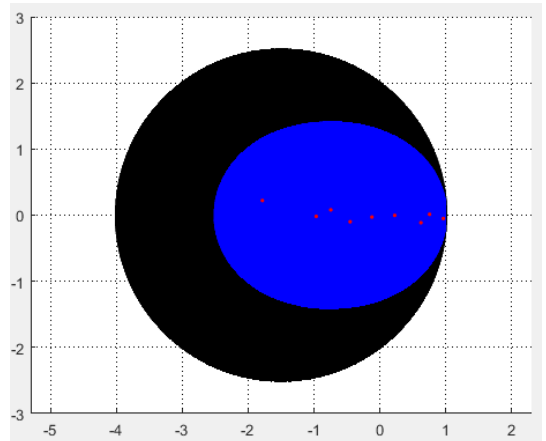
Figure 2. P 2 ( z ) = U 9 ( z ) + 3 U 8 ( z ) − ( 1 − 2 i ) U 7 ( z ) − ( 1 − i ) U 6 ( z ) + iU 4 ( z ) − U 2 ( z ) + 3 iU 1 ( z ) − 2 U 0 ( z )